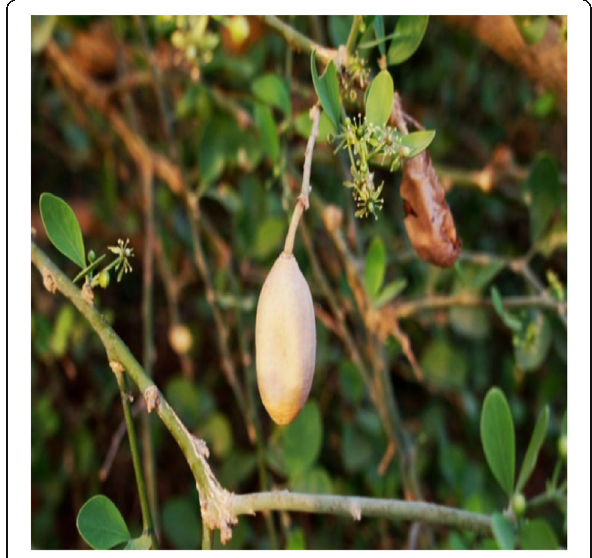
Fig. 11 Balanites aegyptiaca . This endangered species belongs to the plant family Zygophyllaceae (Copy source Jacob Thomas